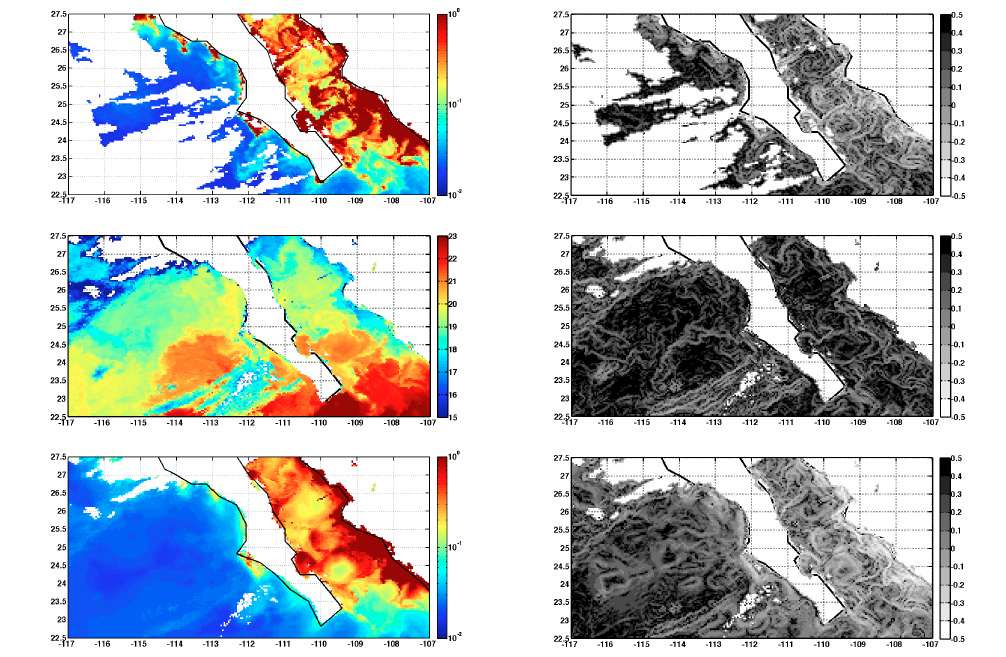
Figure 2. ( top row ) MODIS Chl- a (mg/m 3 ), ( middle row ) MODIS SST ( ◦ C) and ( bottom row ) fused Chl- a (mg/m 3 ), for 1 January 2006 ( left column ) and associated singularity exponents ( right column